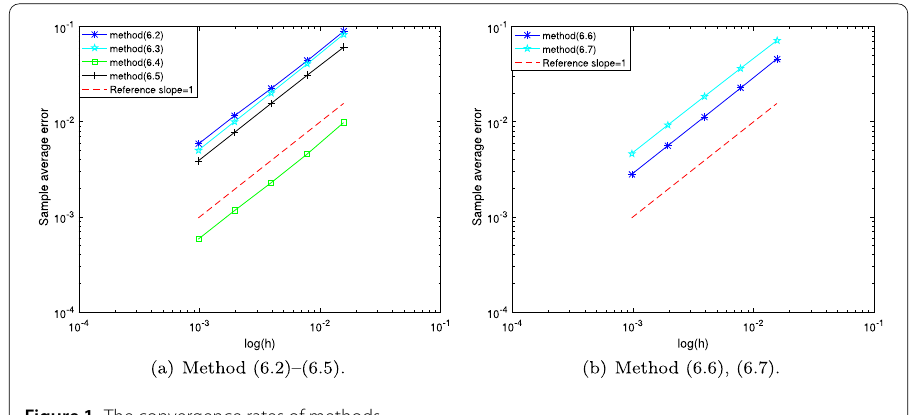
Figure 1 The convergence rates of methods